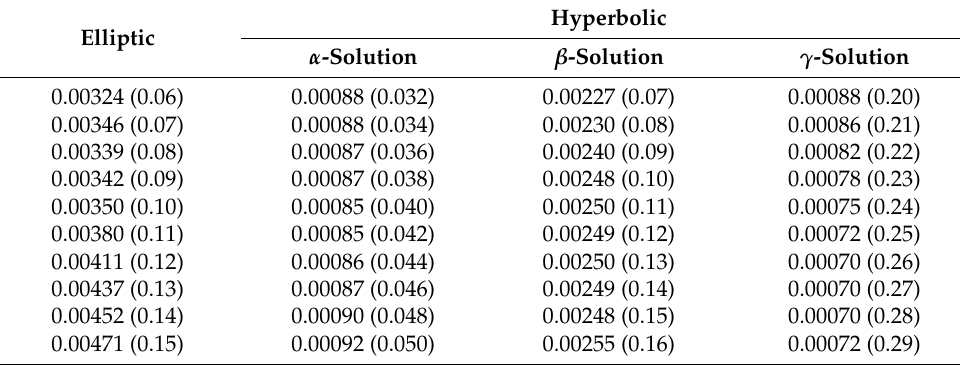
√ Table 8. The MSE of kernel regression method evaluated at bandwidth h (presented in parenthesis) in estimating the critical collapse response function g ( z ) = | f 0 ( z ) | in elliptic and hyperbolic cases based on a training sample of size n = 100.